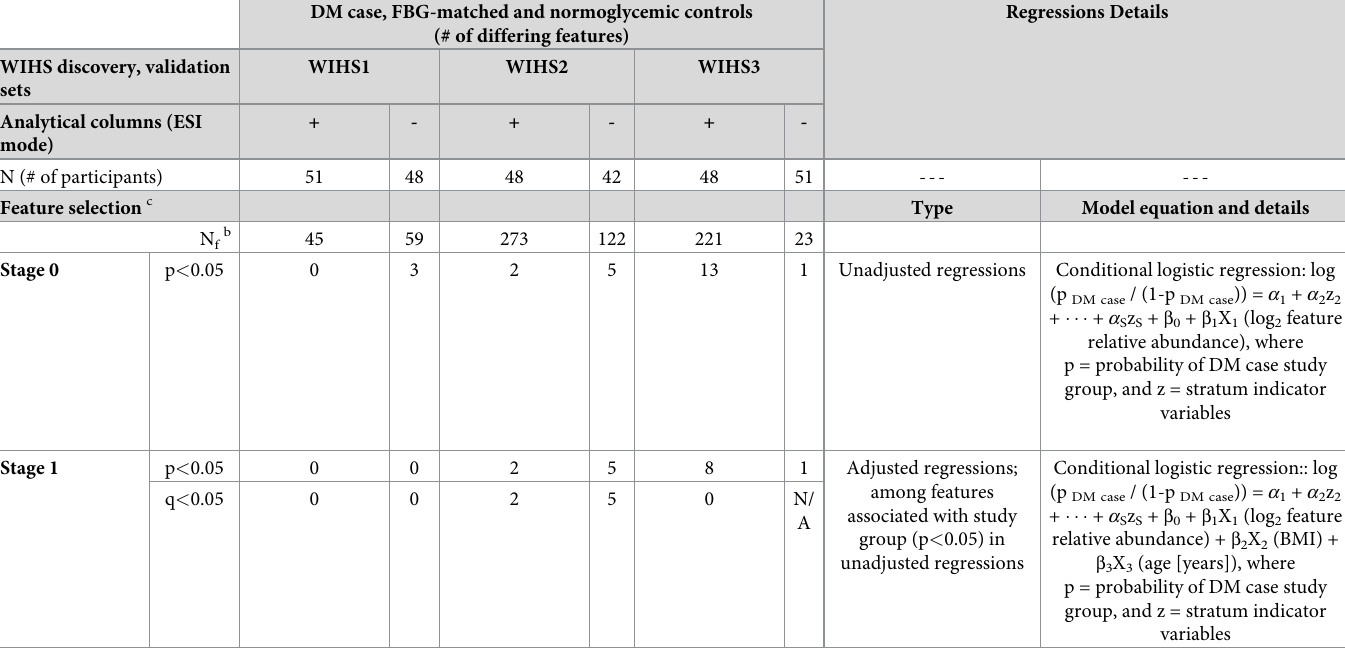
Table 2. Summary of features differing across DM case and control groups. DM case, FBG-matched and normoglycemic controls (# of differing